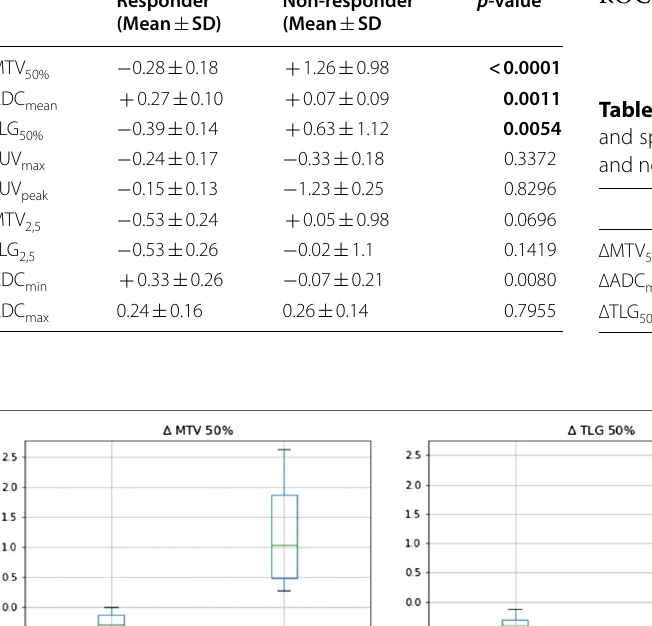
, ∆ADC and ∆TLG 50% mean